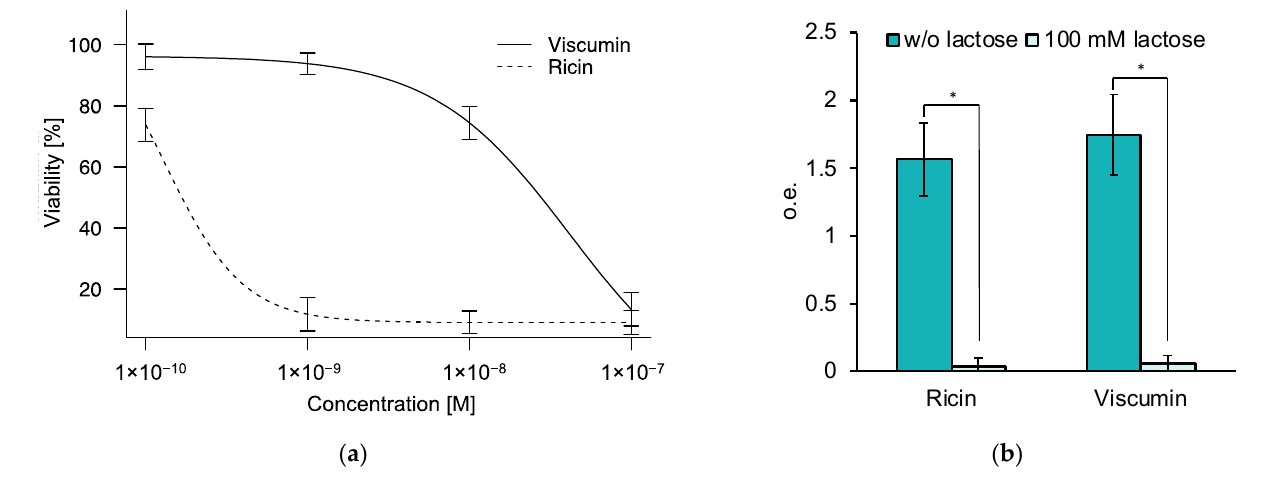
Figure 1. Cytotoxic effect of the RIPs. ( a ) Toxic effect of ricin and viscumin on the colorectal adenocarcinoma HT29 cell line evaluated in relation to cells without treatment. ( b ) Ricin and viscumin binding to the HT29 cell surface under standard conditions and in the presence of 100 mM lactose (* p < 0.01); o.e.—absorption units at 450 nm after background correction. Table 1. Primers used to measure the ribosome inactivation degree by ricin and viscumin. qPCR Fragment Primer Sequences E * PCR-Product, bp